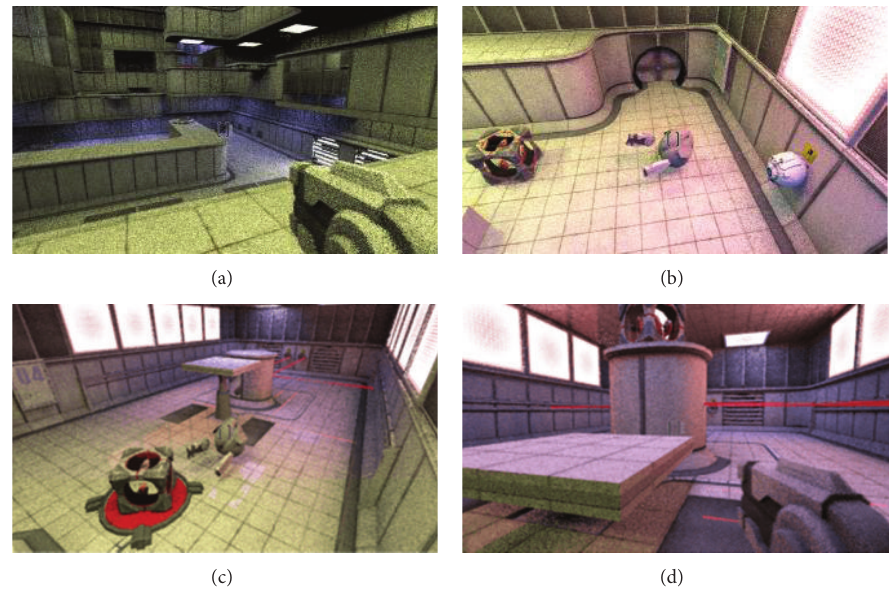
Figure 11: Two views from the “Reflect” game, rendered at 448 × 576 pixels using 16spp, scaled up to 896 × 576